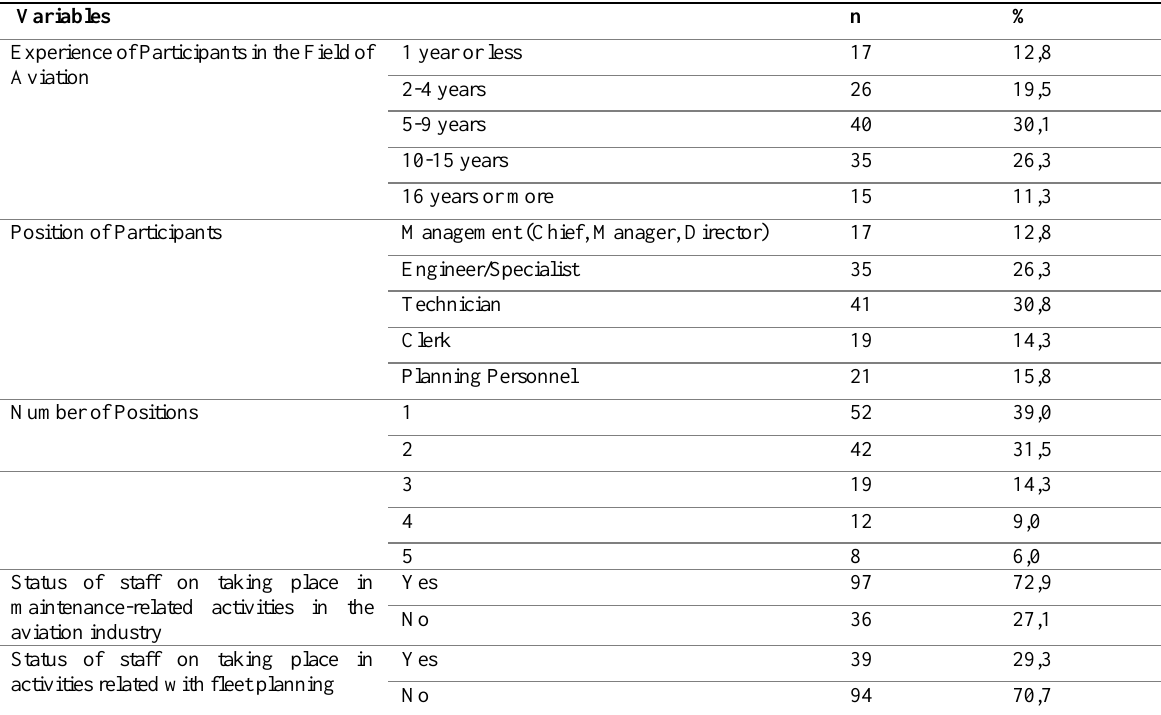
Table 4: Findings on the Experience of Participants in the Area of